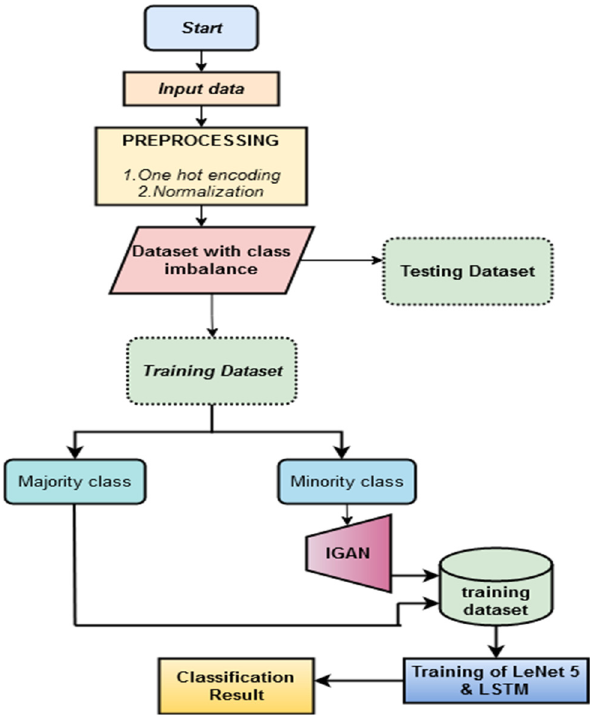
Figure 3. Flowchart of the proposed methodology.